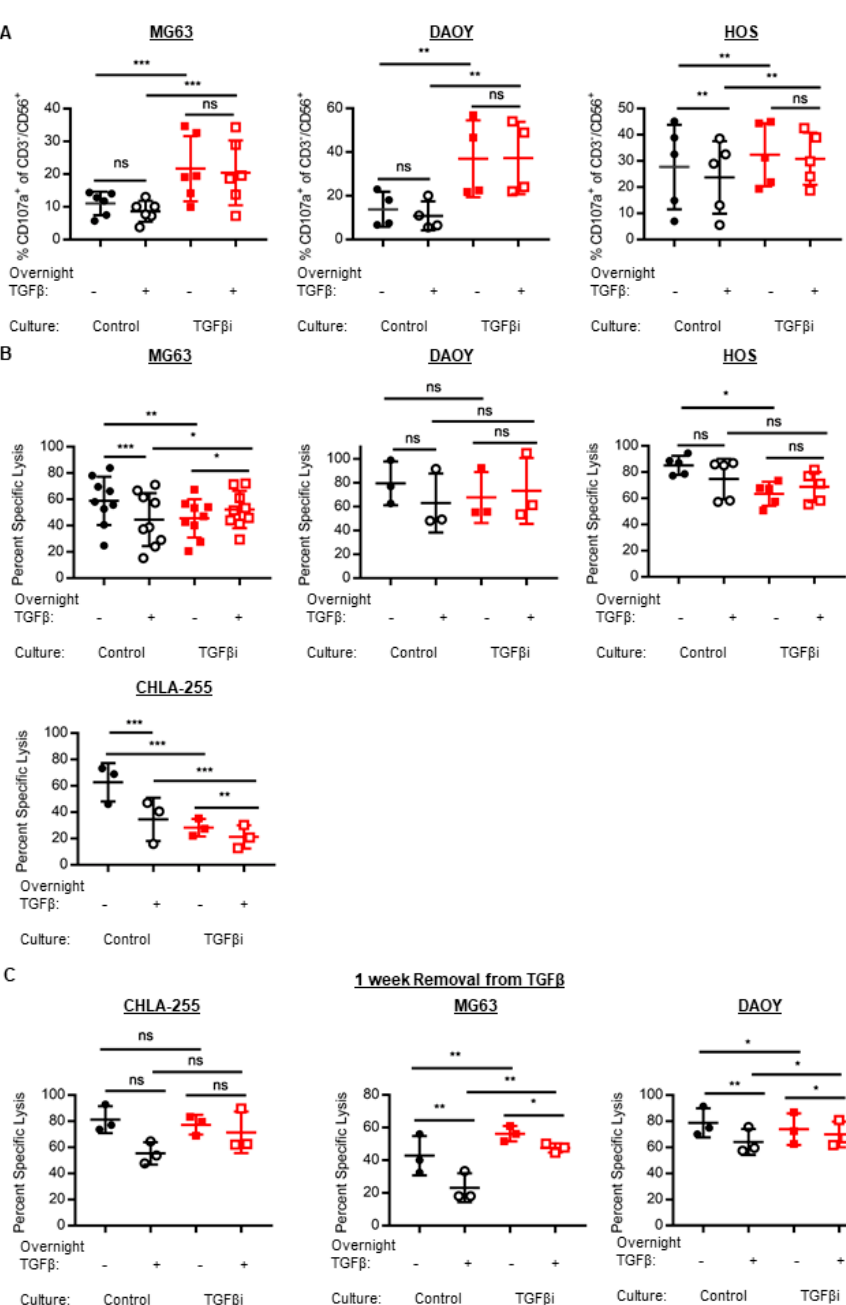
Figure 3. TGF β i generates NK cells with increased degranulation but transiently impairs cytotoxicity. ( A ) Control and TGF β i NK cells from K562mbIL-21 expansions were rested overnight in IL-2 or IL-2 + TGF β and subsequently stimulated with tumor targets for 3 h (MG63, n = 6; DAOY, n = 4; HOS, n = 5) and assessed for degranulation by CD107a. %CD107a + NK cells are corrected for no target controls. ( B ) The control and TGF β i NK cell cytotoxicity was measured using a 4-h calcein-release cytotoxicity assay, following overnight treatment in IL-2 alone or IL-2 plus TGF β . (MG63, n = 9; DAOY, n = 3; HOS, n = 5; CHLA-255, n = 3). ( C ) TGF β i NK cells were removed from TGF β for 7 days ( ± 1 day) and cytotoxicity against CHLA-255, MG63, and DAOY following overnight treatment with IL-2 or IL-2 plus TGF β was measured using a calcein-release assay ( n = 3). Individual data points depicted for all. Lines and bars represent Mean ± SD. Statistical differences were determined by two-way repeated measures ANOVA with Holm-Sidak’s multiple comparisons test. * p ≤ 0.05, ** p ≤ 0.01, *** p ≤ 0.001, **** p ≤